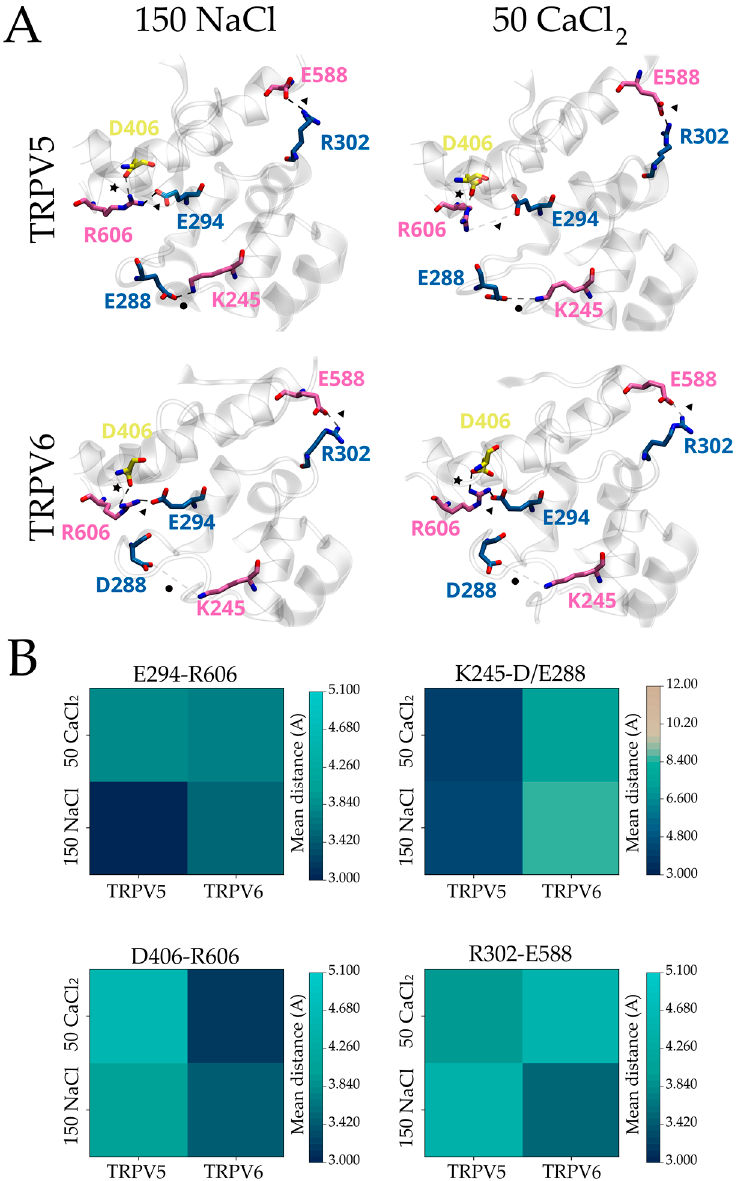
Figure 4. Calcium ions trigger structural changes within the HLH/S2-S3 linker/TDh inactivation motif in mammalian TRPV5 and TRPV6 channels. ( A ) Structural conformation of the three-dimensional HLH/S2-S3 linker/TDh inactivation motif of mammalian TRPV5 and TRPV6 after running 100 ns of fully atomistic molecular dynamics simulations in presence of 150 mM NaCl or 50 mM CaCl 2 (PDBs; TRPV5: 6DMR, TRPV6: 6BOB). Residues of the HLH (blue), S2-S3 linker (yellow), TDh (mauve), and ARD6 (pink) contributing to interdomain interactions are highlighted, as well as the interactions (HLH/ARD: circle, HLH/TDh: triangle, S2-S3 linker: star). ( B ) Heat maps representing the average distance between the pairs of residues in panel A during the molecular dynamics simulations in presence of 150 mM of NaCl or 50 mM of CaCl 2 . Bars on the right of each heat map represent the color scale of the mean distance during the simulation time.